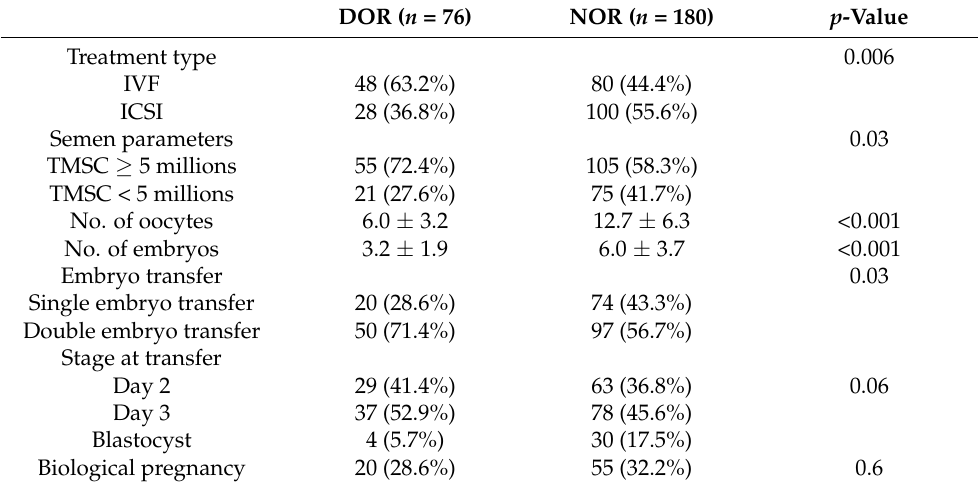
Table 2. IVF cycle outcomes for patients with Diminished Ovarian Reserve (DOR) compared to patients with Normal Ovarian Reserve (NOR). Values are shown as mean ± SD or n (%). DOR ( n = 76) NOR ( n = 180) p -Value Treatment type 0.006 IVF 48 (63.2%) 80 (44.4%) ICSI 28 (36.8%) 100